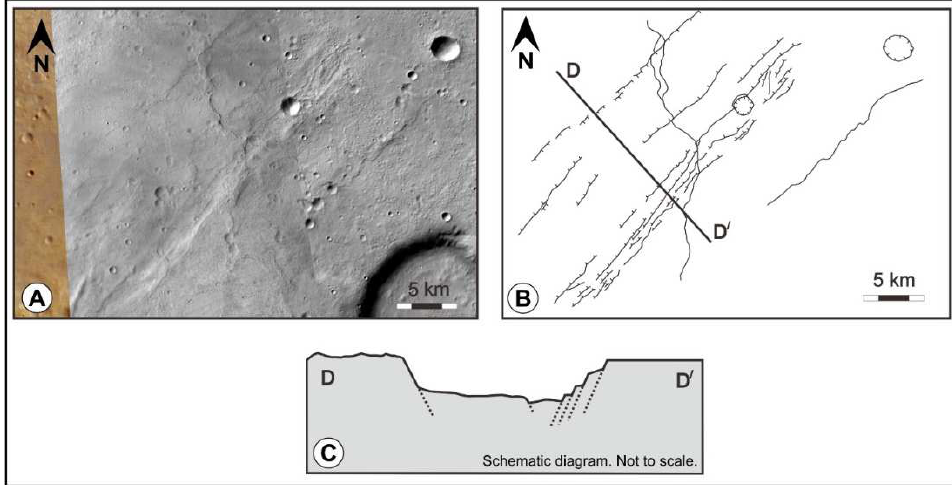
Figure 4. ( A ) NWH extensional structures are shown in the CTX image with its central location 27°55′ E/28°15′ S. ( B ) High-resolution view of a 10 km wide NWHG. Detailed structures are drawn over Figure A. ( C ) graphical representation of the topographic profile section D–D′. domal shape of the basement along the WH and NWH regions. The domal region is ~2 km